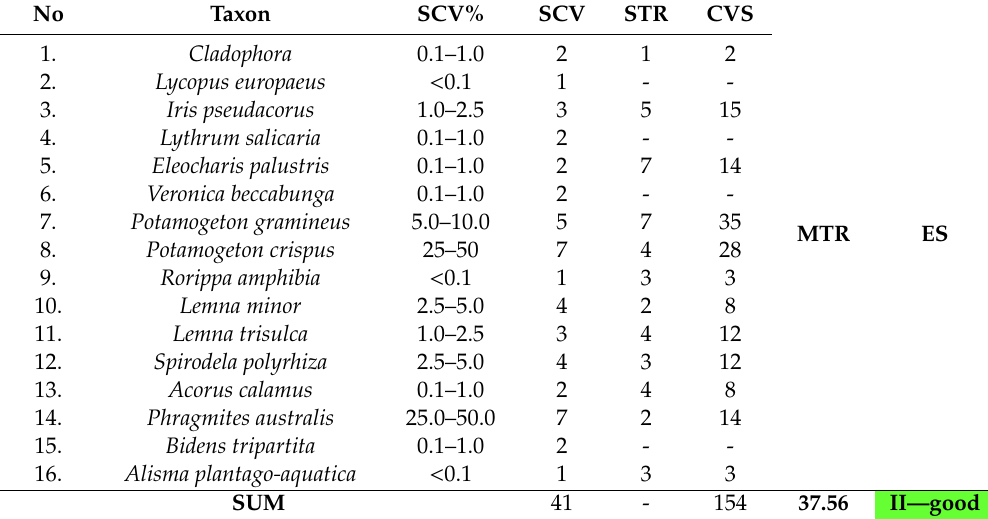
Table 10. Summary of MTR results, May 2017, section above the barrage on the Ś l ę za.